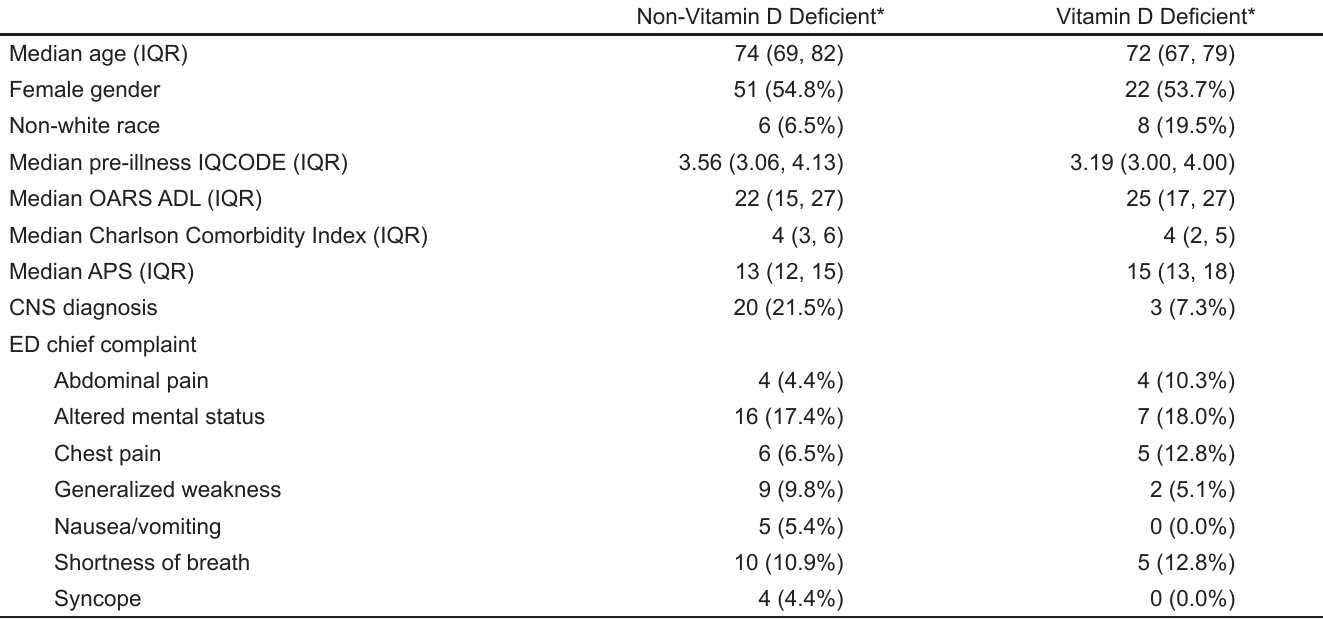
Table. Patient characteristics and